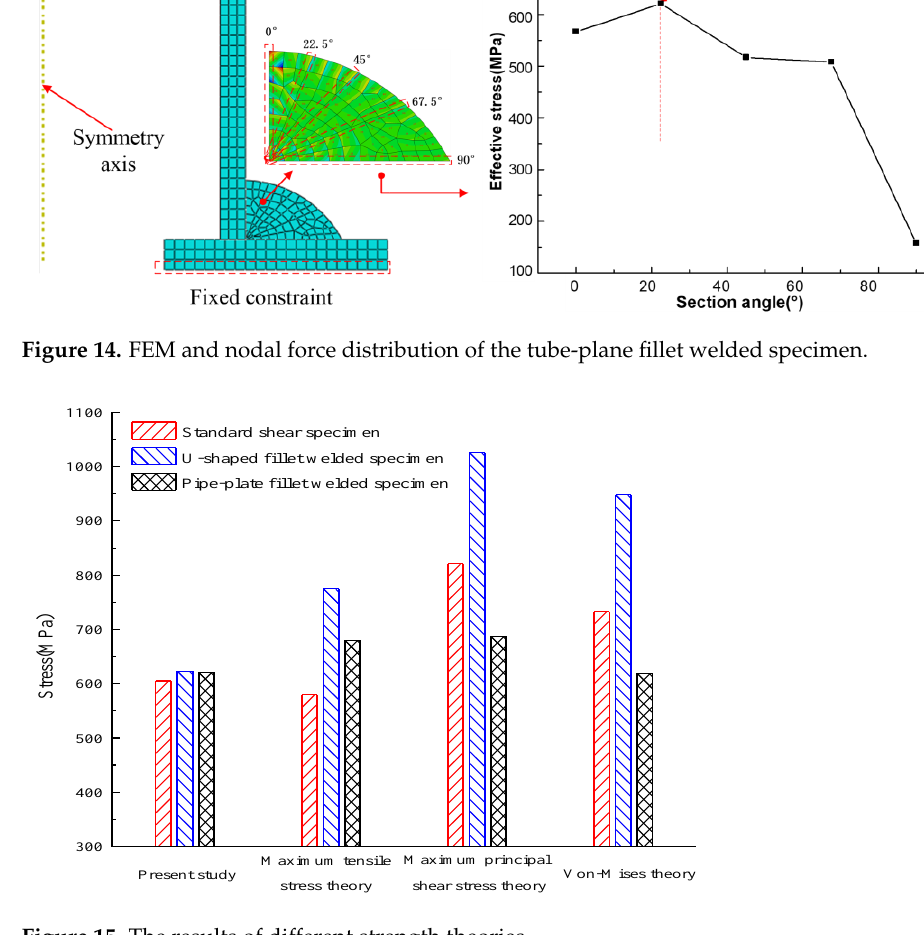
Figure 15. The results of different strength